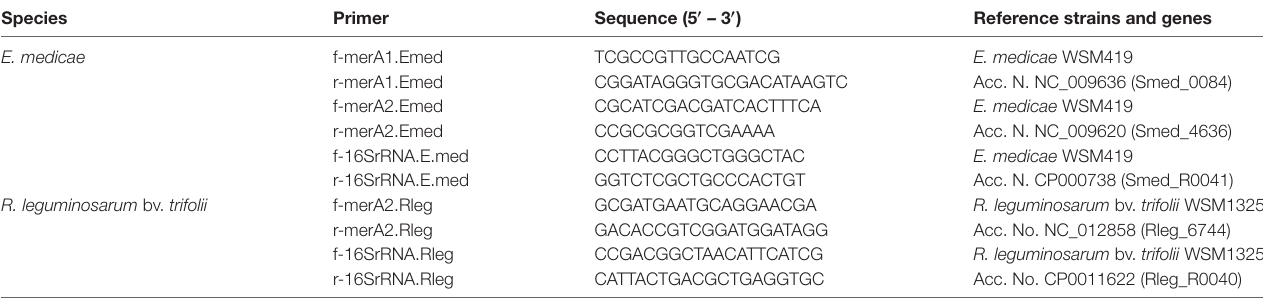
TABLE 1 | Primers used for qPCR amplification of merA genes. Species Primer Sequence (5 (cid:48) – 3 (cid:48)